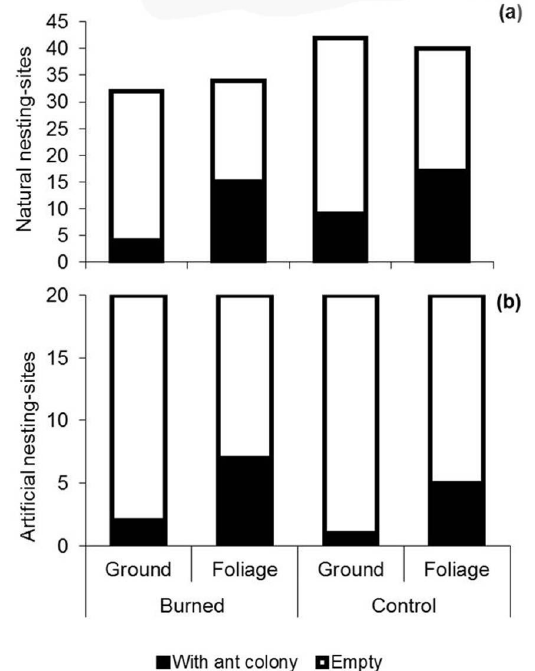
Fig 2 . Number of natural (a) and artificial (b) nesting-cavities placed on the ground and foliage, occupied by ant colonies in burned and recovered areas of Cerrado. The burned area presents lesser availability of nest-sites, but the proportion of occupied nests was not different between burned and non-burned habitats for natural (p = 0.04) and artificial (p = 0.36) cavities. The proportion of occupied nests was higher in vegetation for natural (p = 0.04) and artificial (p = 0.01) cavities.